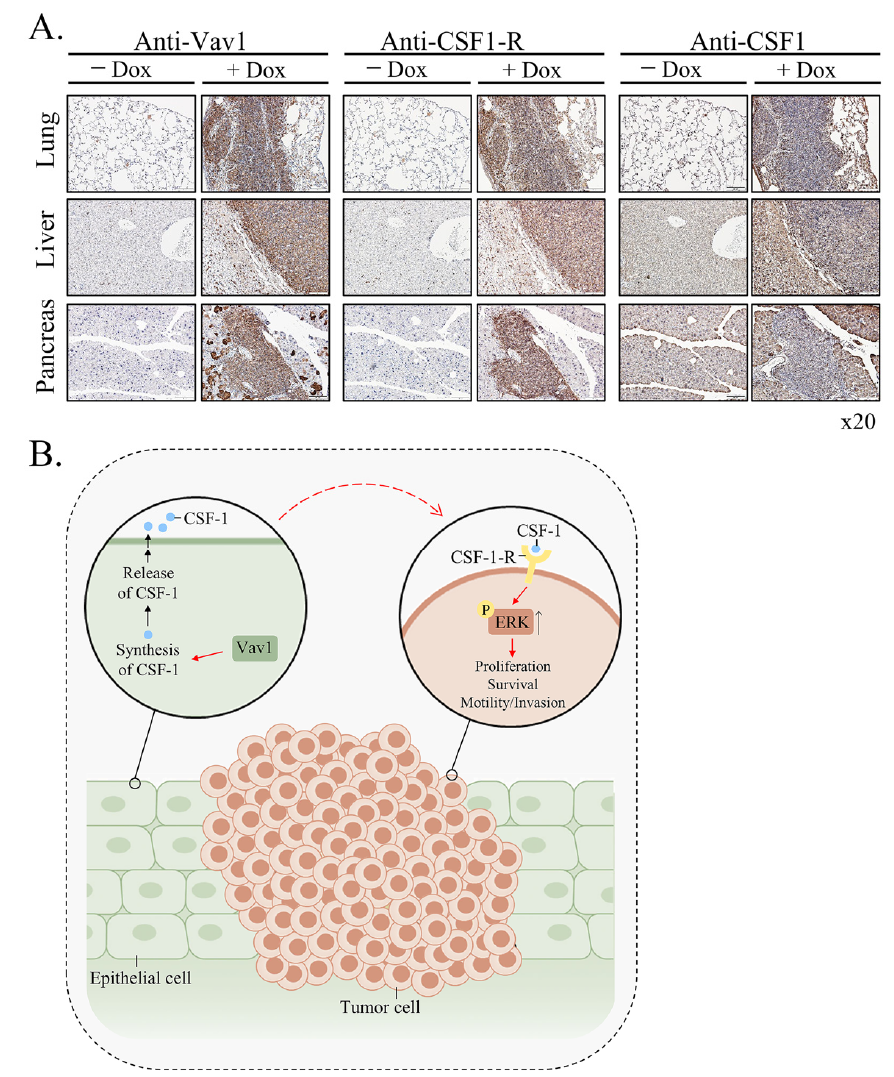
Figure 6. Mechanism of generation of B-cell Lymphomas in Rosa Vav1 mice. ( A ) Sections of lung, liver, and pancreas from Rosa Vav1 mice either treated (+Dox) or non-treated ( − Dox), 12 months post transgene induction stained with anti-Vav1, anti-CSF-1R and anti-CSF1 antibodies are depicted. Representative pictures are shown. Magnification at × 20. ( B ) The model proposed for generation of B-cell lymphomas from due to the aberrant expression of Rosa Vav1 in epithelial cells suggests that CSF-1 secretion from the epithelial compartment activates the CSF-1R on B-cells, leading eventually to the development of B-cell